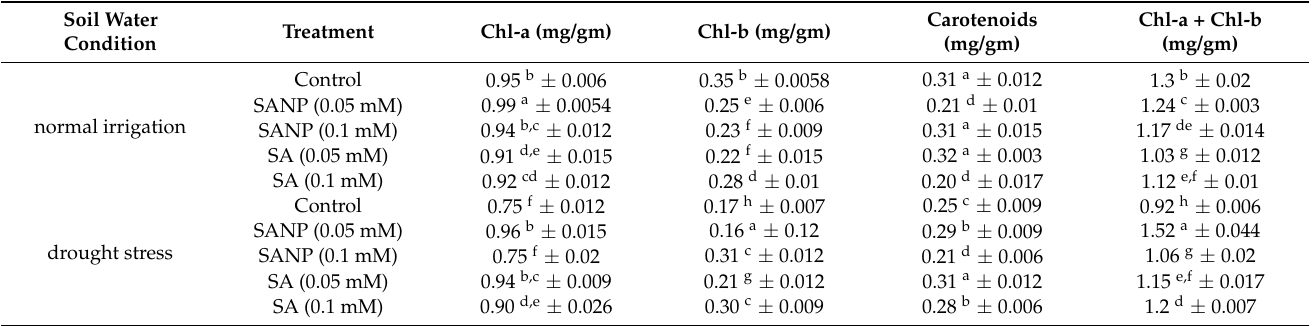
Table 3. Effect of drought stress, bulk SA, and SANPs on chlorophyll a and b, carotenoid, and chlorophyll a + b (mg/gm of a plant